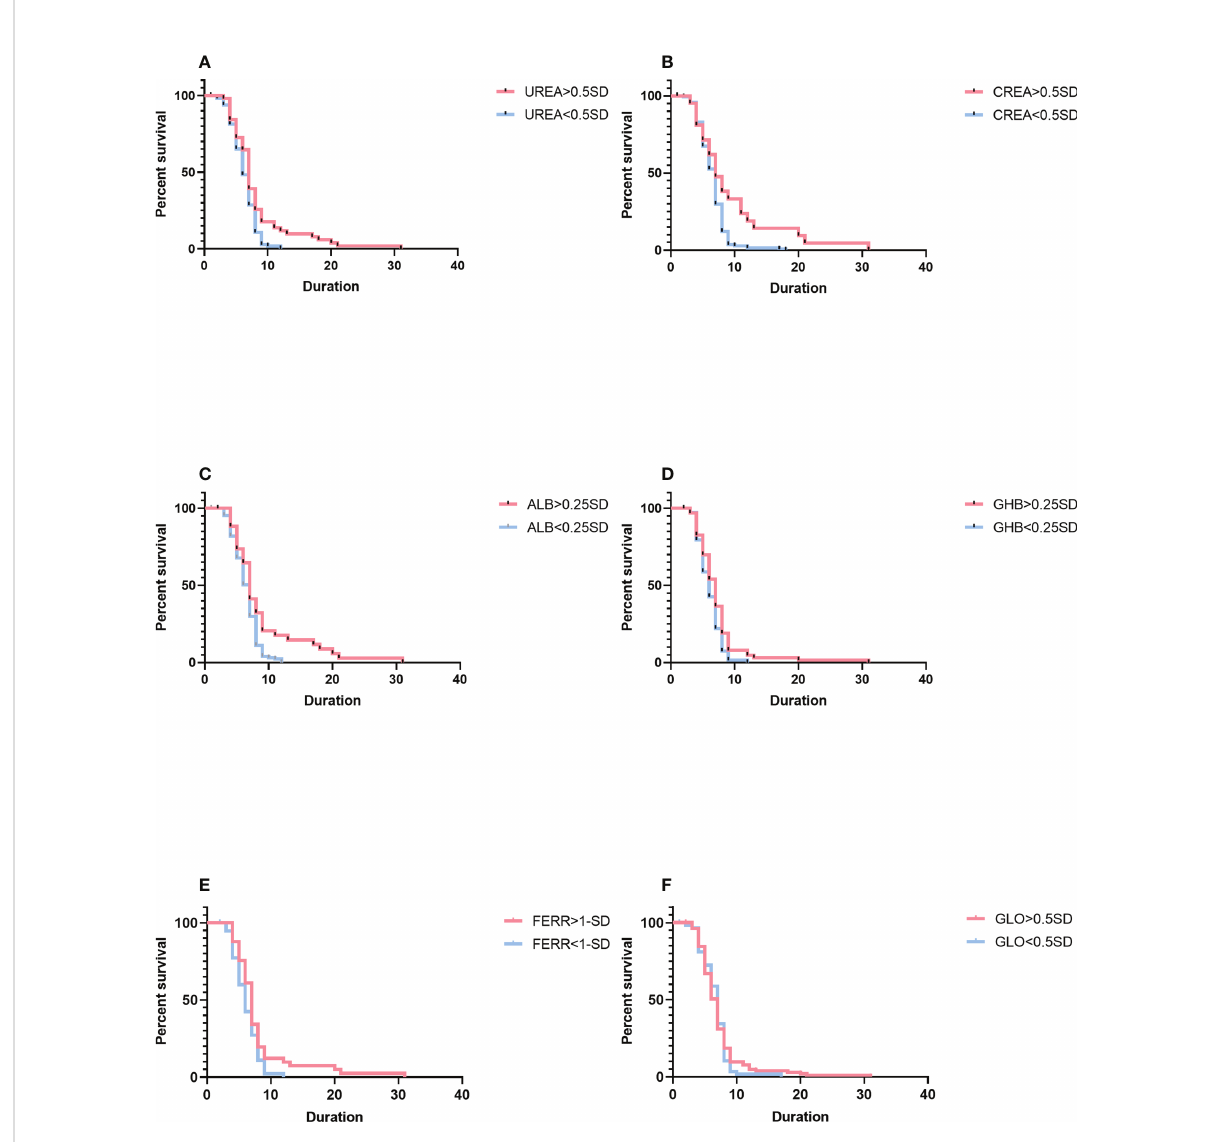
FIGURE 3 Comparison of survival curves using the log-rank test. (A) The variation for UREA ≥ 0.5 SD versus< 0.5 SD. (B) The change for CREA ≥ 0.5 SD versus< 0.5 SD. (C) The change for ALB ≥ 0.25 SD versus< 0.25 SD. (D) The change for GHB ≥ 0.25 SD versus< 0.25 SD. (E) The change for FERR ≥ 1.0 SD versus< 1.0 SD. (F) The variation for GLO ≥ 0.5 SD versus< 0.5 SD. Blue lines show patients with a shorter duration of parasite clearance; red lines show patients with a longer duration of parasite clearance. Duration is indicated in days. SD, standard deviation; GHB, g -hydroxybutyrate dehydrogenase; FERR, ferritin; GLO,